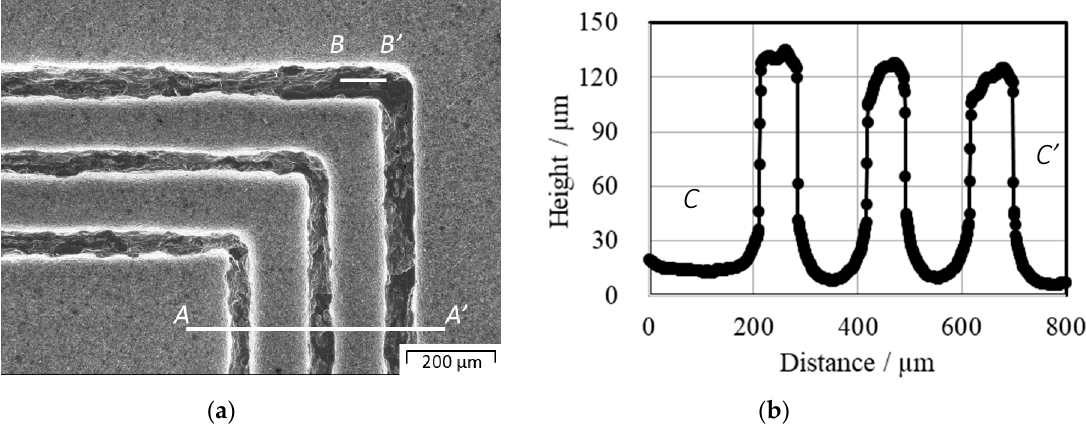
Figure 10. Enlarged SEM image and height distribution of the multi-punch array. ( a ) Enlarged SEM image of micro-textured AISI316 micro-punch array, ( b ) height distribution of the multi-punch array measured along the line A–A’ . The average punch width at 90 µm height position is 75 µm and the average punch height is 117 µm.